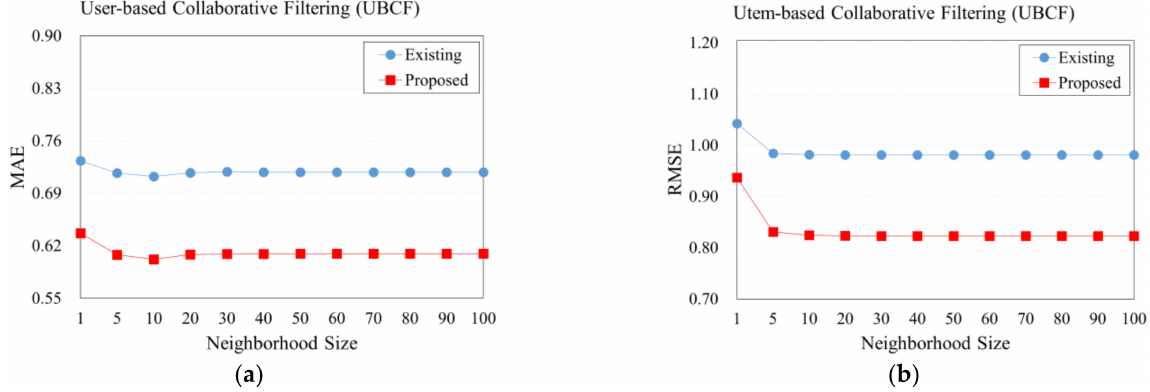
Figure 6. Prediction performance of MAE ( a ) and RMSE ( b ) of UBCF model.